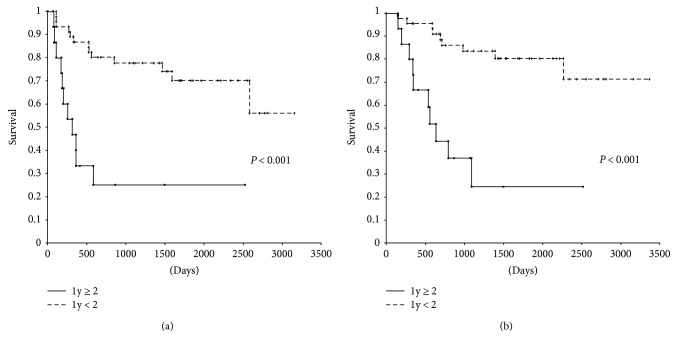
Disease-free survival and overall survival for two categories (lower incidence (ly < 2) and higher incidence (ly ≥ 2)).